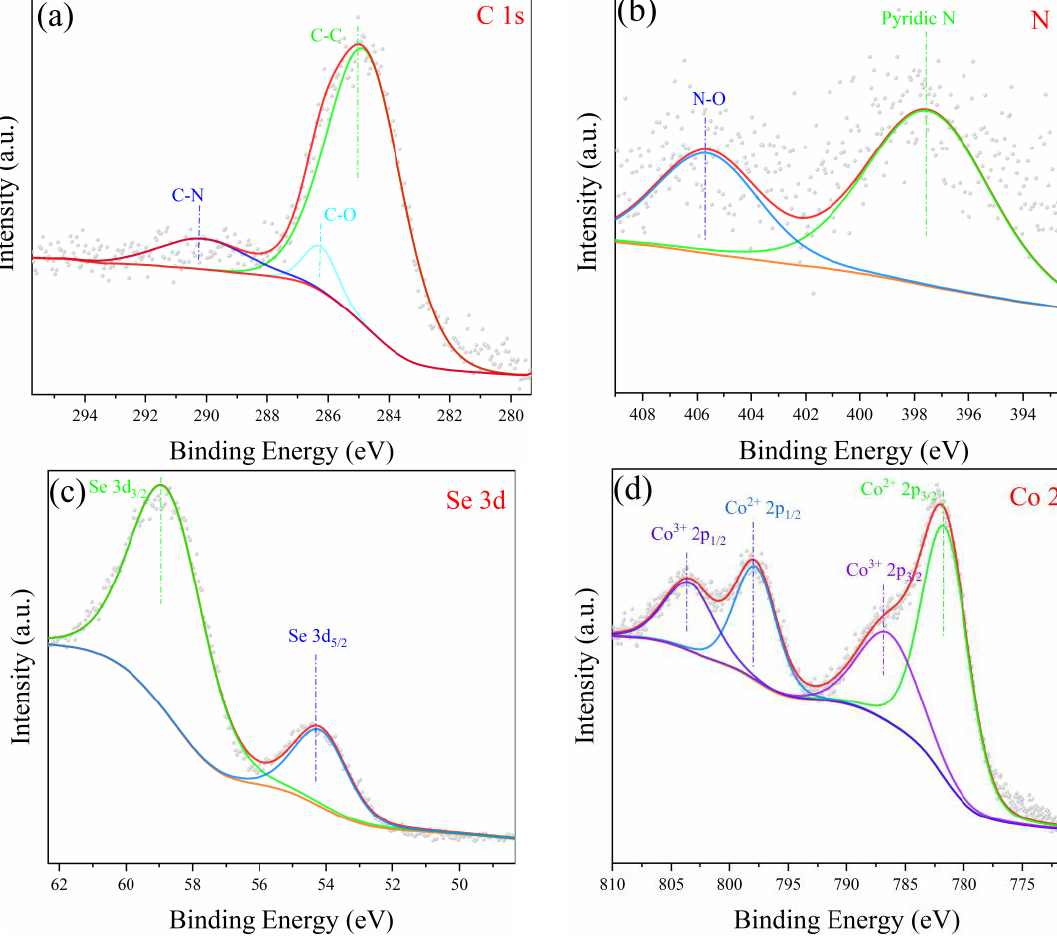
Figure 5. XPS spectra of C 1s ( a ), N 1s ( b ), Se 3d ( c ), and Co 2p ( d ) spectra for CS/1NC@3.